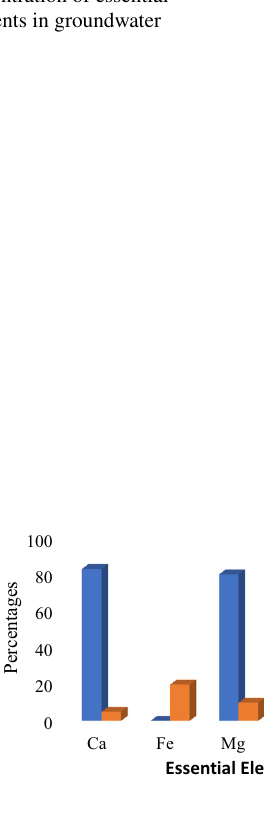
Fig. 2 Deficiency/toxicity of essential elements in